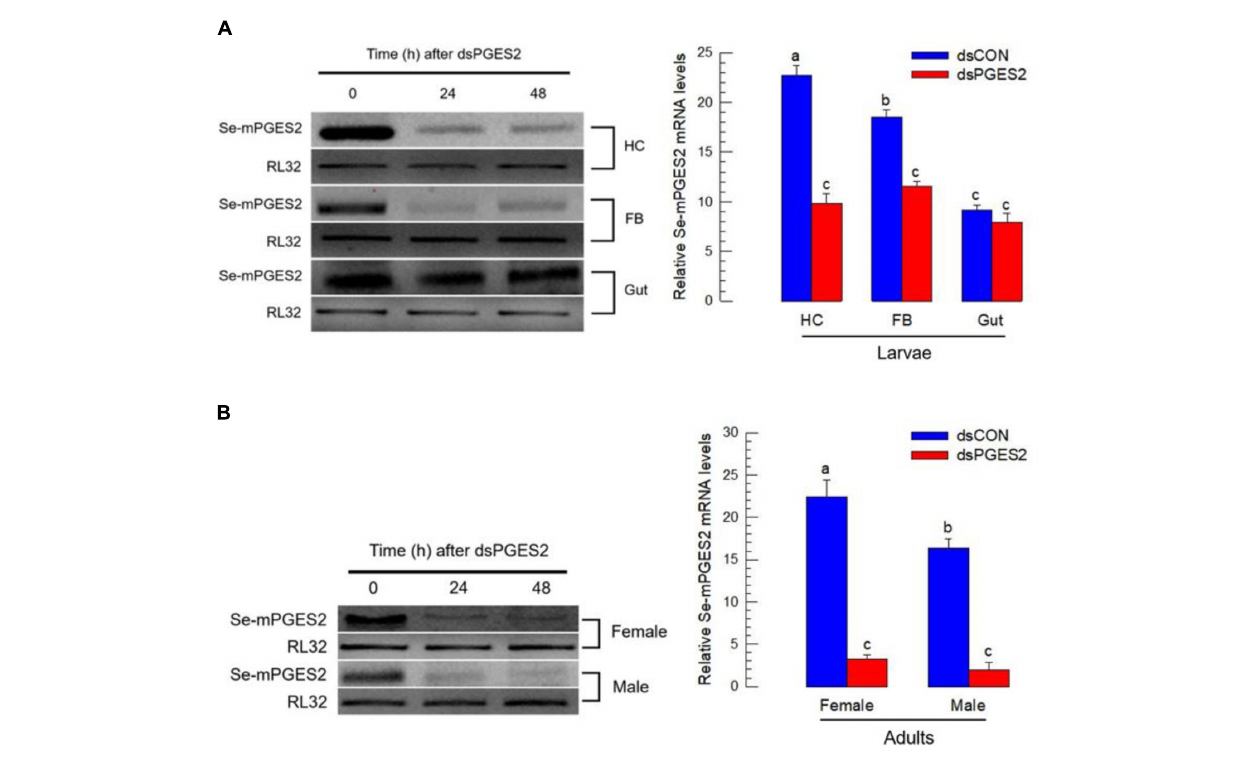
FIGURE 3 | RNA interference (RNAi) of Se-mPGES2 in larvae and adults. One mg of gene-specific dsRNA (“dsPGES2”) was injected into L5D1 or 5 days old pupae. A viral gene, CpBV302 , was used as a control dsRNA (“dsCON”). (A) Effect of RNAi on Se-mPGES2 expression in indicated tissues of L5 larvae: hemocyte (“HC”), fat body (“FB”) and midgut (“Gut”). (B) Effect of RNAi on Se-mPGES2 expression in male and female adults. Each treatment was independently replicated three times. Different letters indicate significant differences among means at Type I error = 0.05 (LSD